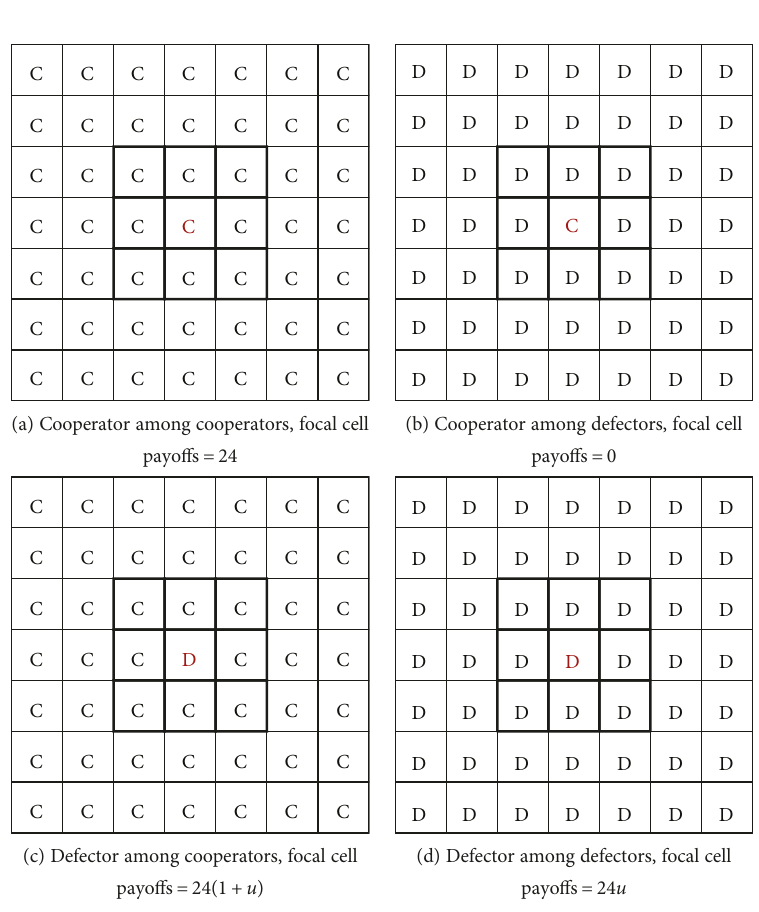
Figure 4: An illustration of the update rules. A focal cell plays the prisoner ’ s dilemma game with cells in its extended Moore neighborhood; scores are weighted depending on the distance between the neighbor and the focal cell. After all cells in the grid are assigned fi tness values, each cell competes with one random neighbor.